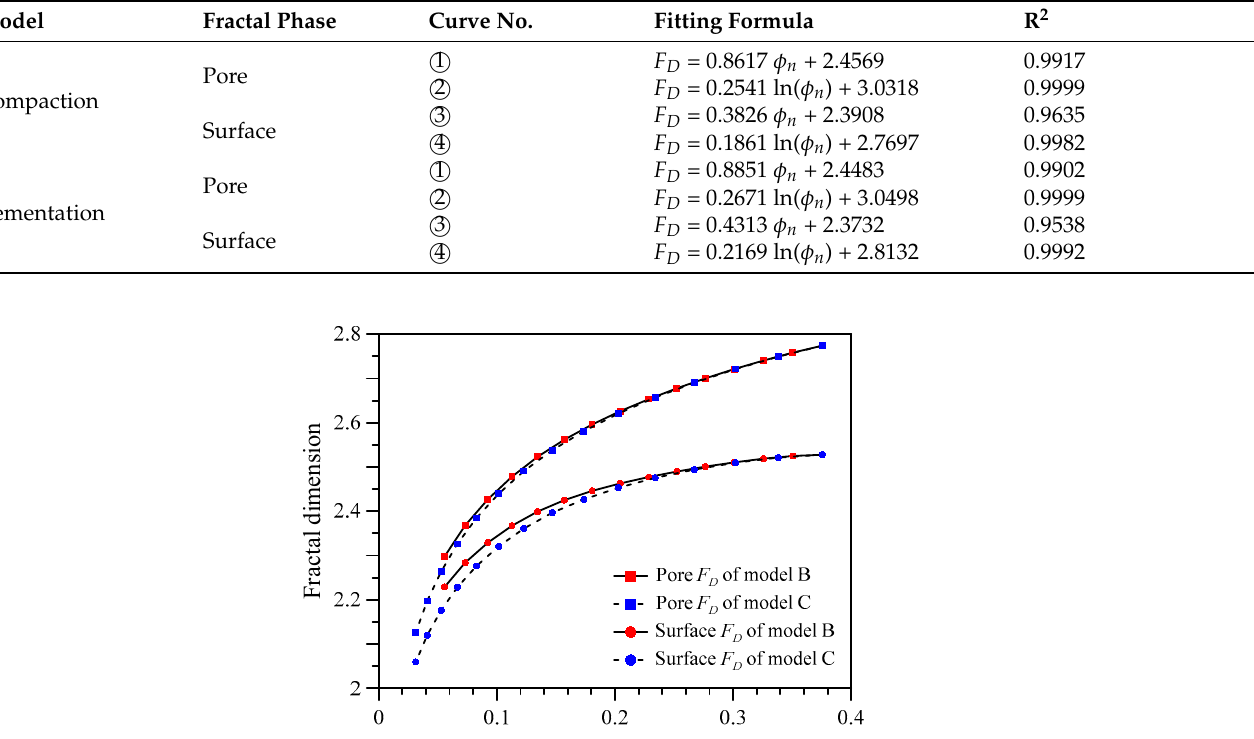
15 of 18 Figure 9. Fitting curves of F D versus ϕ n in ( a ) compaction model and ( b ) cementation model.